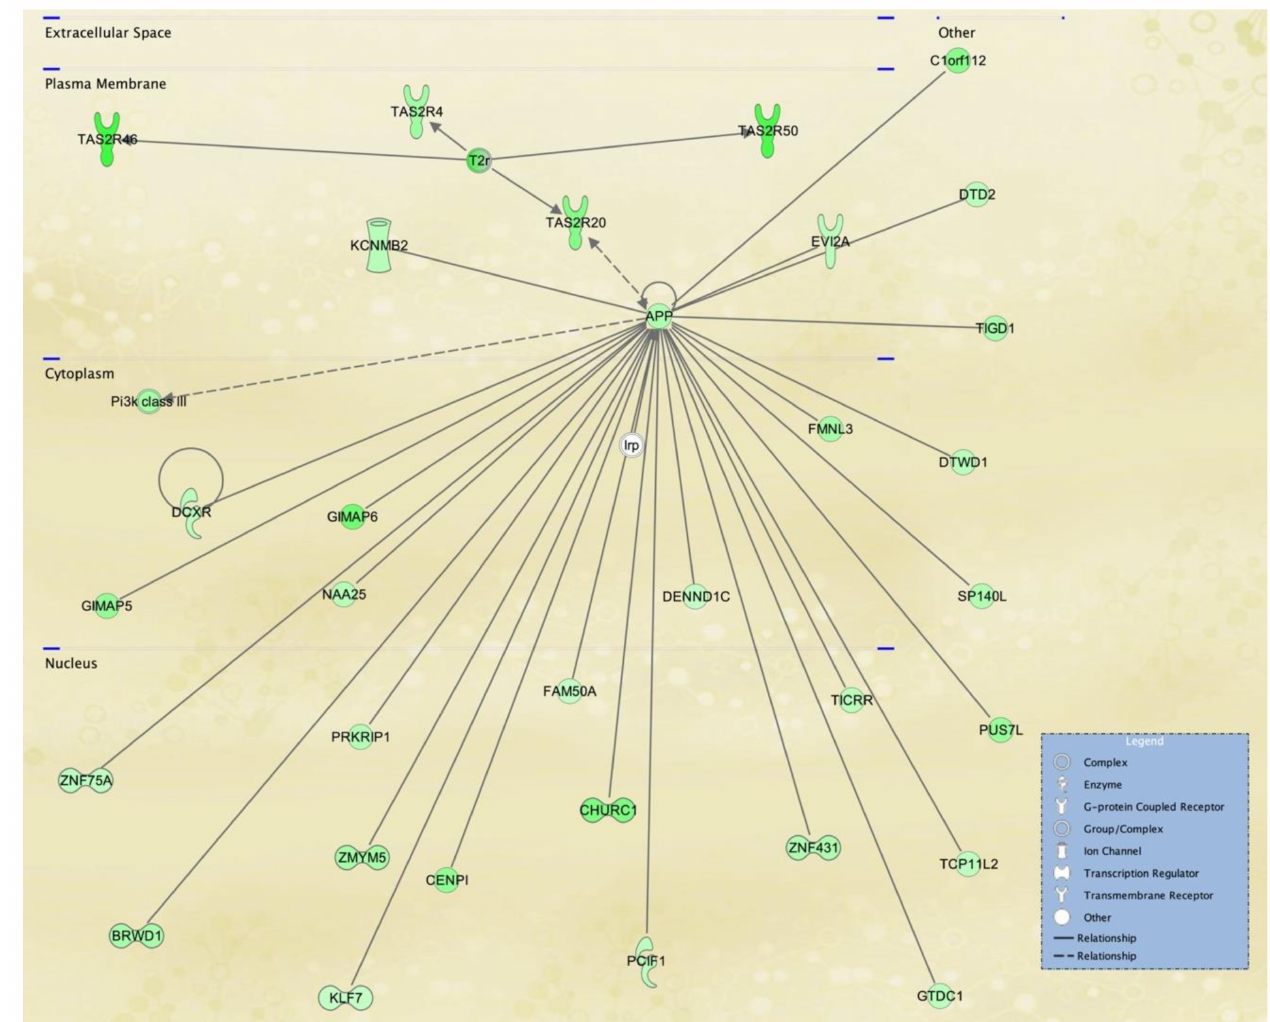
Figure 7. Hereditary disorder, metabolic disease, organismal injury and abnormalities network affected in lymphoblastoid cells derived from an SS patient. IPA network 4 is centered in the amyloid beta precursor protein (APP), which is also found in the WikiPathways for TGF β signaling and the IPA Canonical Pathway for Reelin signaling in neurons. Several olfactory receptor genes are down-regulated and practically all of the genes in this causal